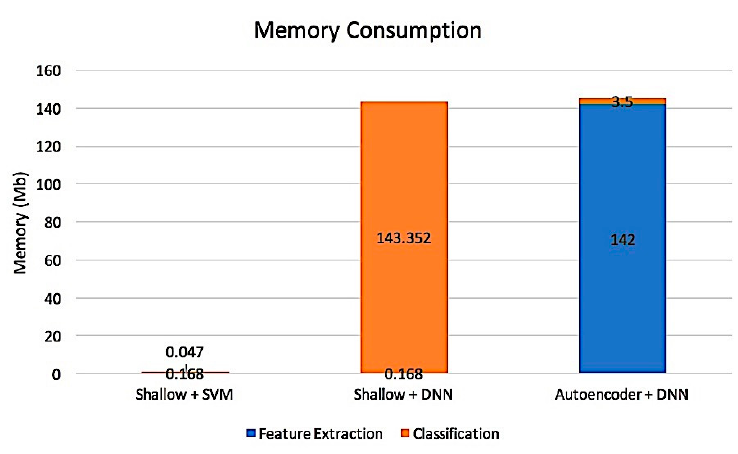
Figure 8. Memory consumption based on 3 classifiers, SVM, DNNs and DL.